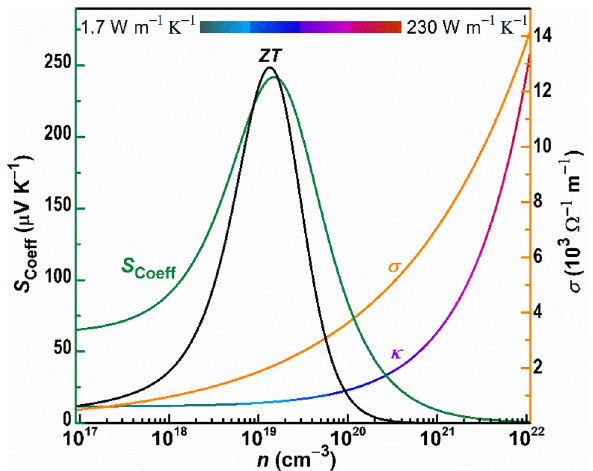
Fig. 2 The dependence of S σ , and κ on carrier concentration ( n ) Coeff , for polycrystalline Pb 1− x Sn x Te at 300 K. ZT reaches its maximum only for a very narrow window of n . A change in temperature shifts all these curves in a non-trivial manner, resulting in a maximum ZT at a different n . Furthermore, synthesis protocols may drastically change the presented values. S coeff and σ values were adapted from Refs. [18] and [19], while κ was adapted from Ref.